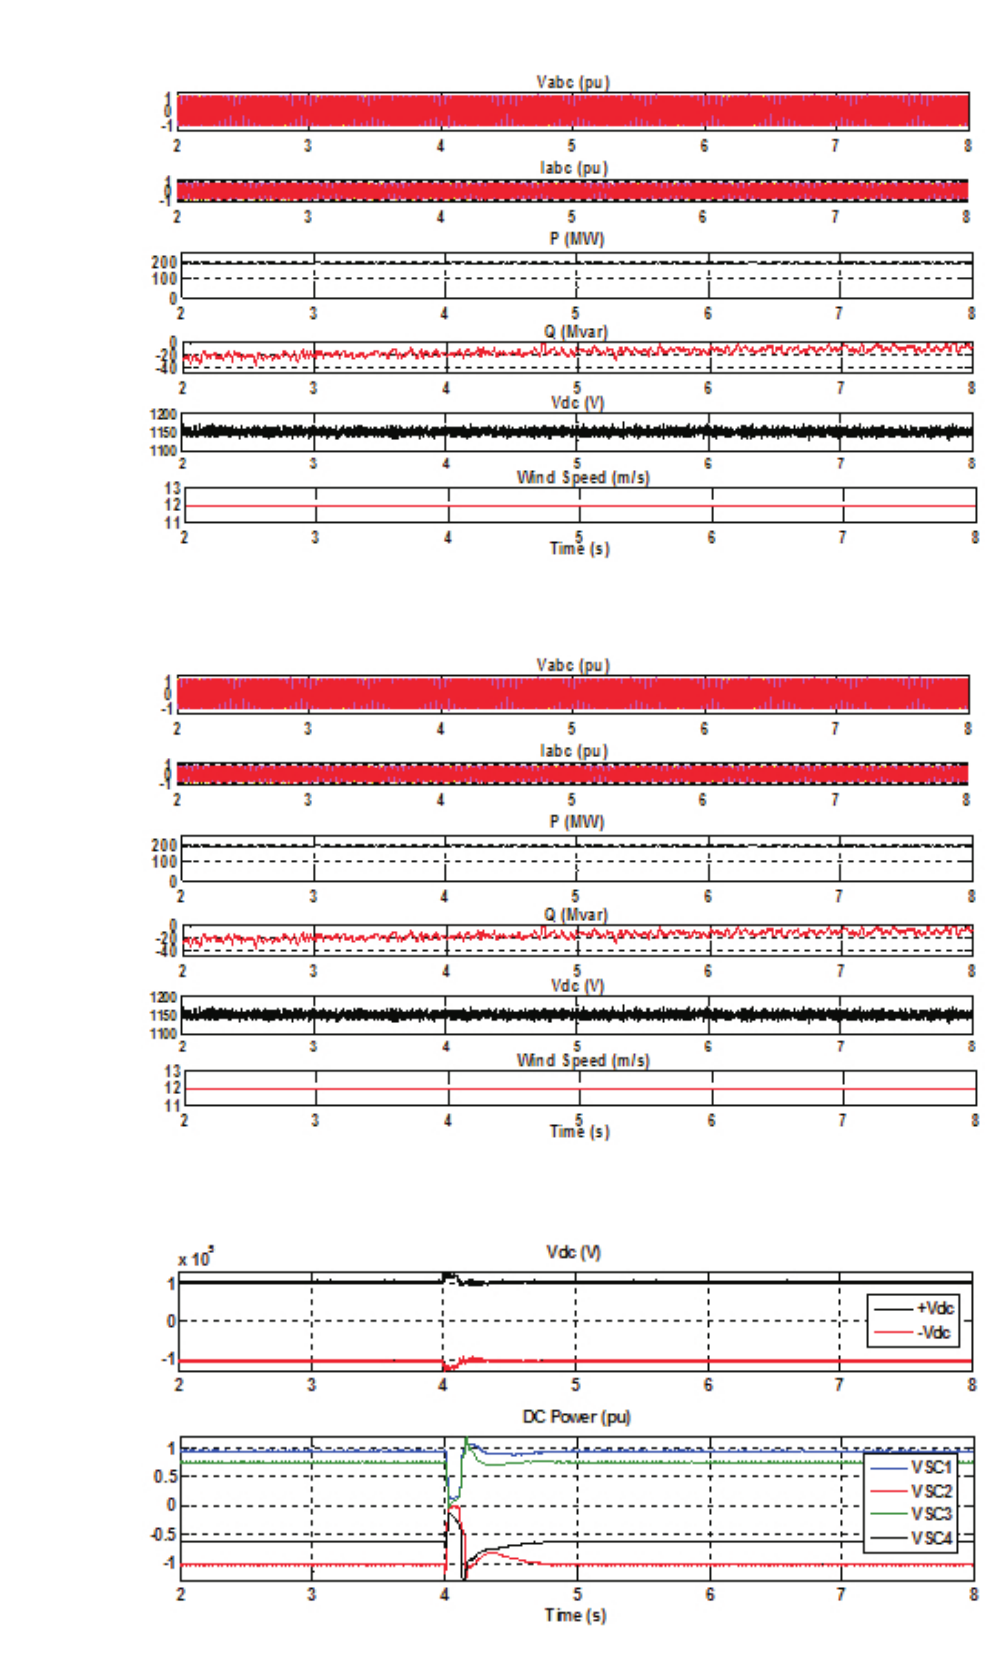
Figure 4: Dynamics of (a) VSC1 (b) VSC2 (c) VSC3 (d) VSC4 (e) Wind farm and (f) DC link parameters for a 3-phase fault at onshore AC grid with a duration of 5